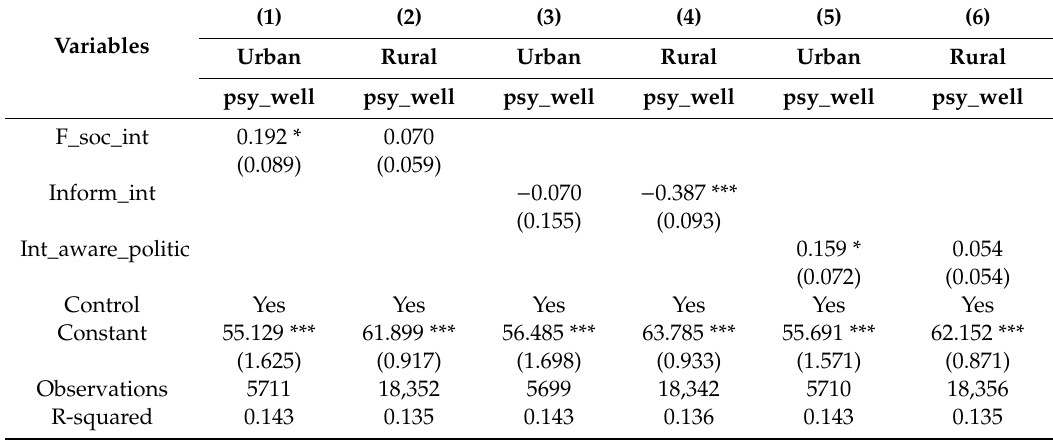
Table 4. Mechanism analysis (1) of the di ff erent e ff ects of the Internet on the two categories of hukou